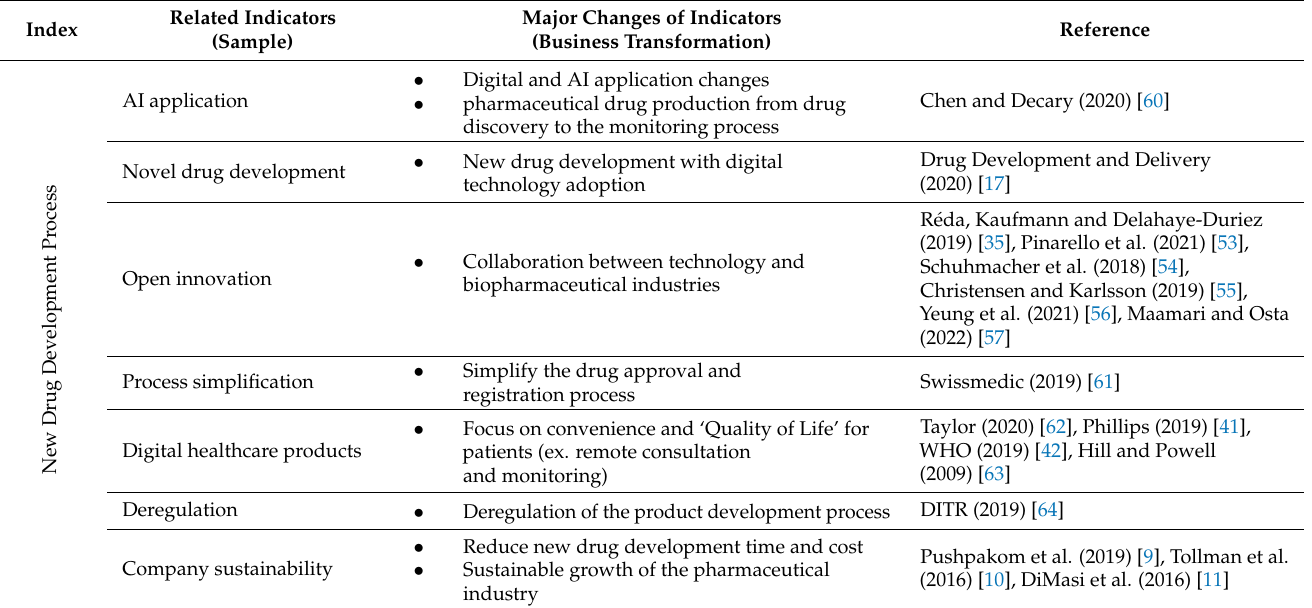
Table 2. Digital Value Chain for Drug Development and Business Transformation